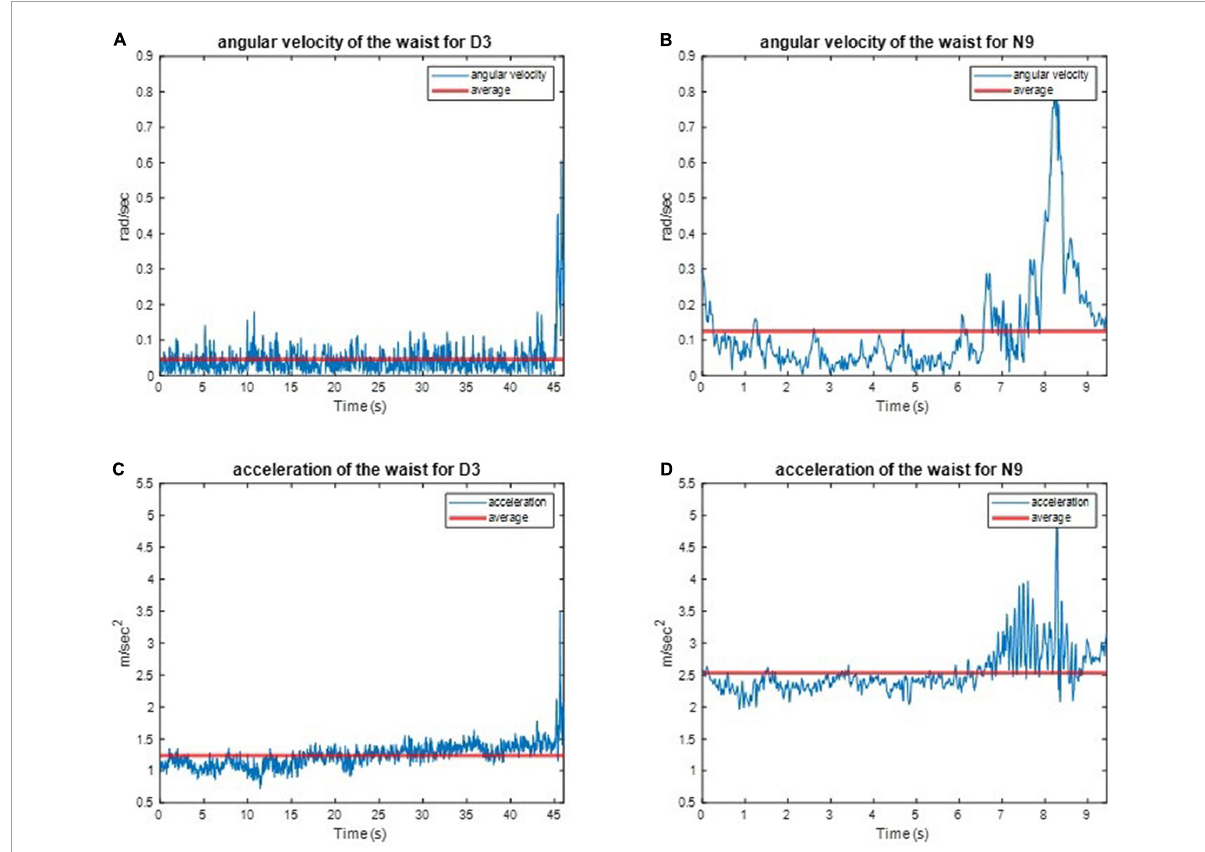
FIGURE9 The absolute angular velocity and acceleration of D3 and N9 when standing on the dominant foot with eye open. The dancer made much smaller body movements than the non-dancer control maintain stability. (A) The absolute angular velocity of D3. (B) The absolute angular velocity of N9. (C) The absolute linear acceleration of D3. (D) The absolute linear acceleration of N9.